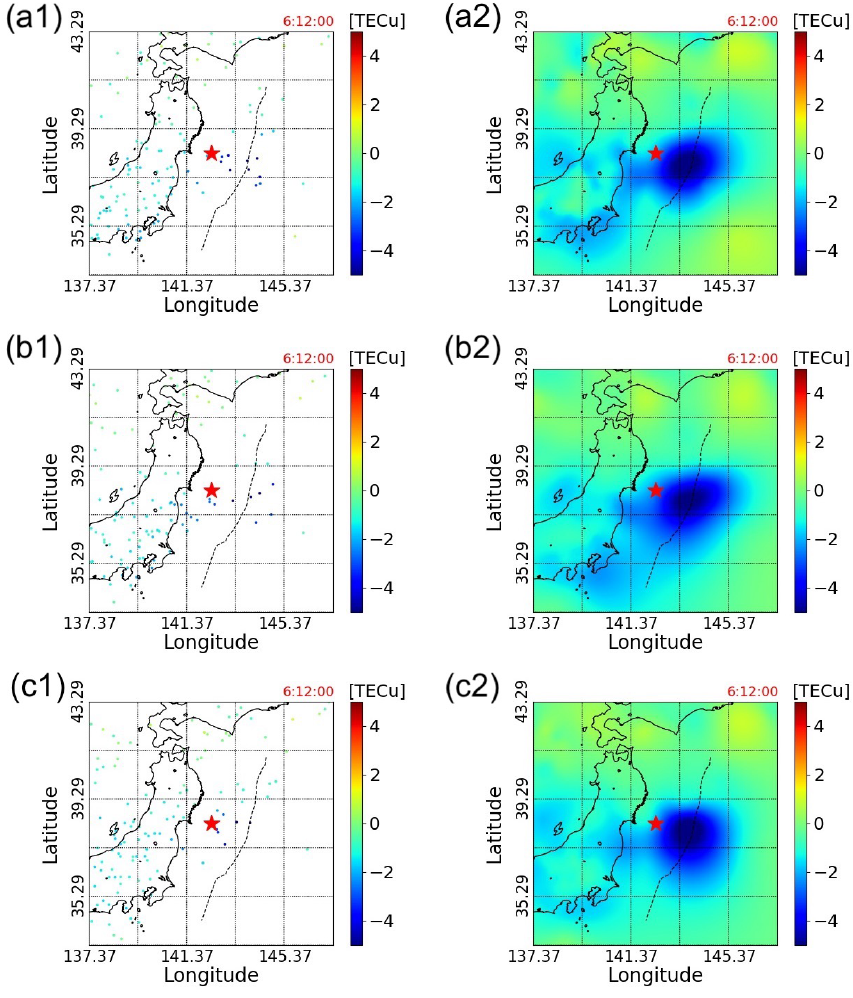
Figure 6. Three different sparse-data distributions, random 0, random 3, and random 8, and these fitting surfaces mapped in two dimensions at 06:12:00 (UTC). The black dashed line indicates the location of the axis of the Japan